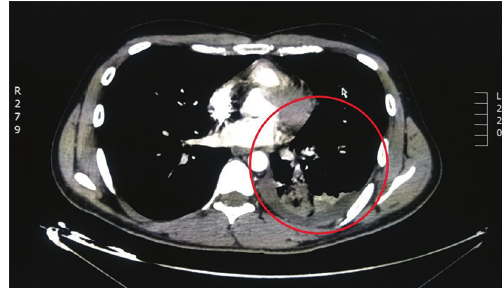
FIGURE 2. Chest CT – May 16, 2016.